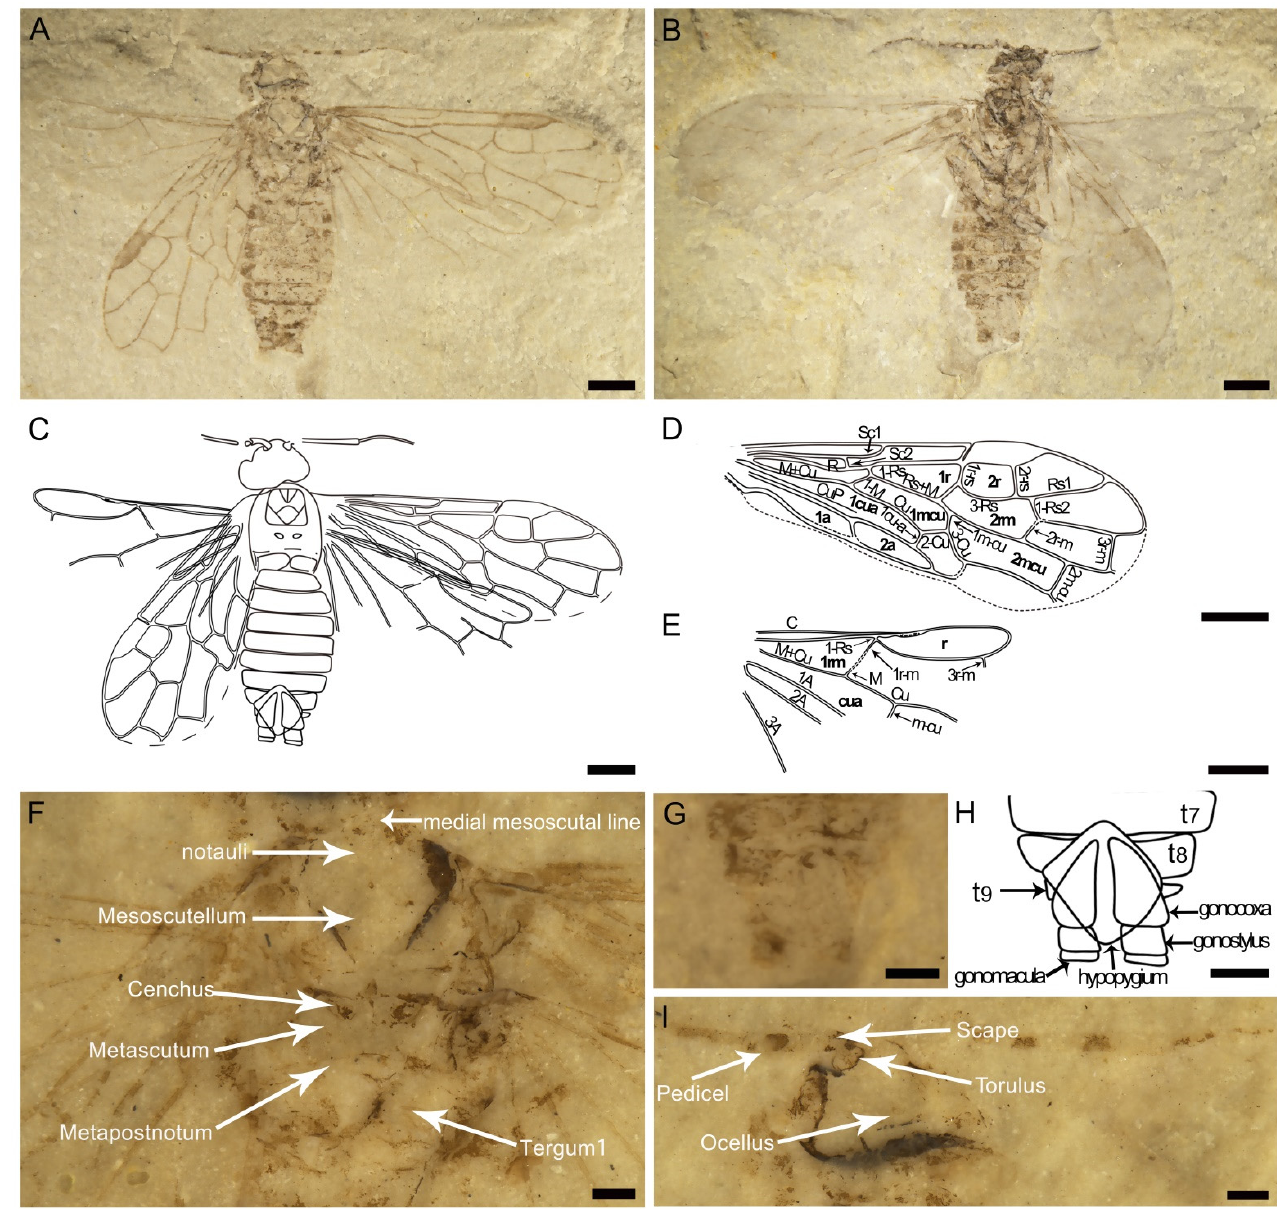
Figure 2. Photographs of Scleroxyela cephalota sp. nov., holotype (specimen CNU-HYM-NN-2021004) male. ( A ), dorsal view as preserved. ( B ), ventral view as preserved. ( C ), line drawing of dorsal view with forewings and hind wings. ( D ), line drawing of forewing. ( E ), line drawing of hind wing. ( F ), Photo of body under alcohol. ( G ), Photo of genitalia under alcohol. ( H ), line drawing of genitalia. ( I ). Photo of head under alcohol. Scale bars: 1 mm in ( A – E ); 0.25 mm in ( F – I ). Abbreviations: t 7 –t 9 , tergum 7–9.